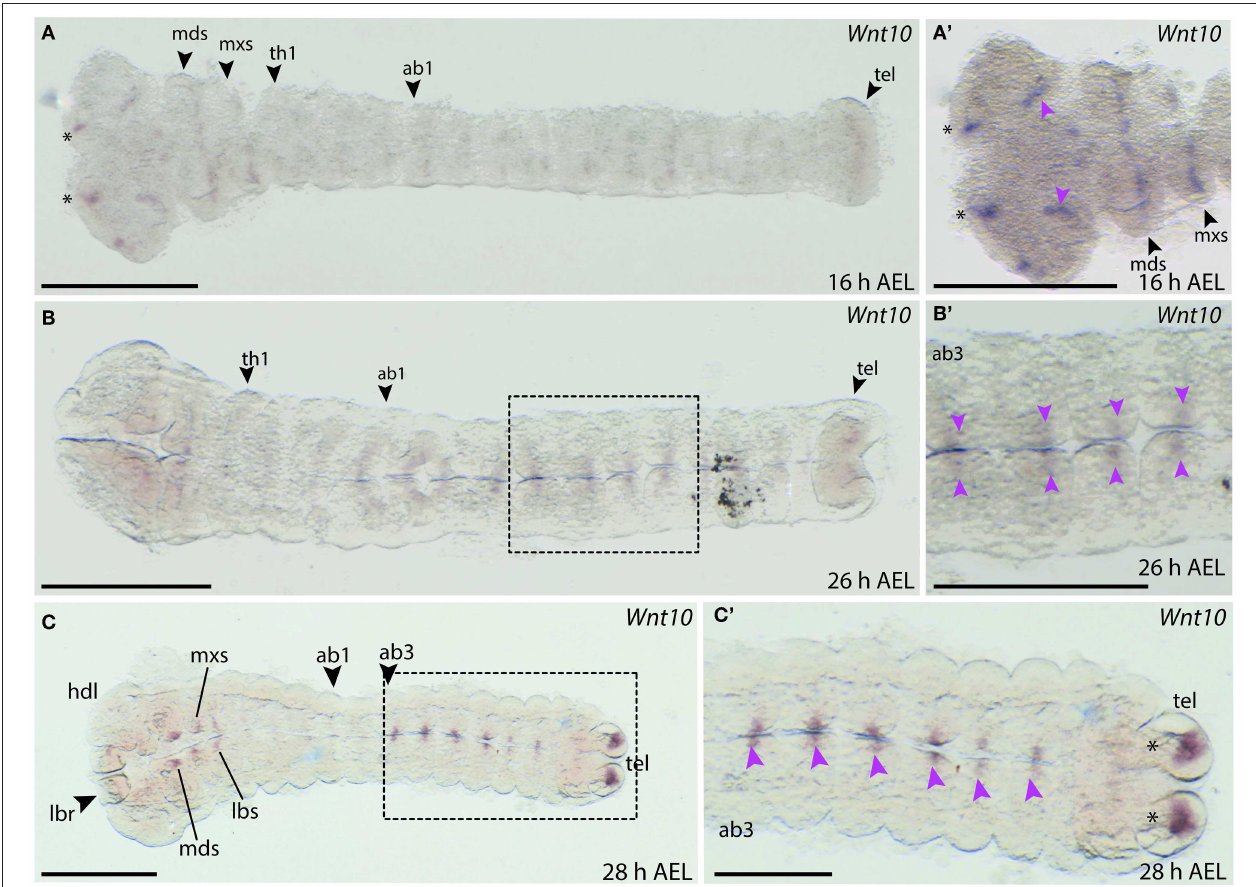
FIGURE 10 | Wnt10 expression during B. anynana embryogenesis. (A) Expression around 16h AEL is only detectable in the head structures of the embryo. (A ′ ) Higher magnification of the head region of this embryo at 16h AEL, indicating expression in the labrum (asterisks), the head lobes (pink arrowheads) and in the segments. (B) Expression at 26h AEL becomes more restricted on either side of the neurogenic furrow, along the neurogenic furrow. (B ′ ) Magnification of Wnt10 expression at 28h AEL (pink arrowheads). (C,C ′ ) Expression around 28h AEL only in the abdominal segments, indicated by pink arrowheads. All images are orientated with anterior to the left if not otherwise stated. H, hour; AEL, after egg laying; th1, thoracic segment 1; ab1, abdominal segment 1; hdl, head lobe; mds, mandibular segment; mxs, maxillary segment; lbr, labrum; lbs, labial segment; tel, telson. Scale bar: 400 µ